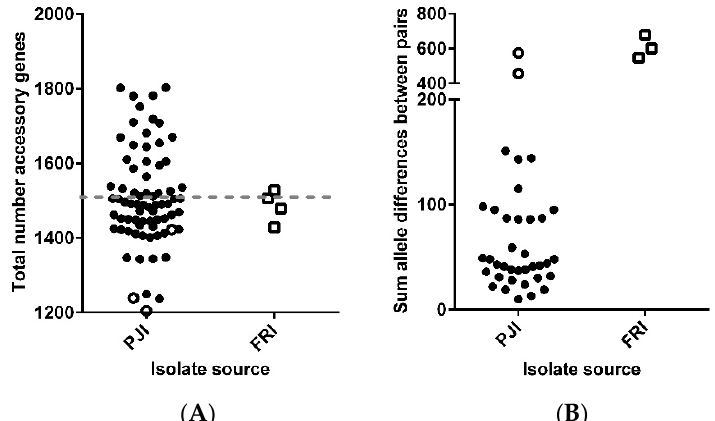
Figure 5. Molecular diversity within the accessory genome of the 77 isolates from 37 patients; ( A ) total number of accessory genes present (dashed line represents average number of genes); and ( B ) sum allele differences within the pairs in 2936 accessory genes. Open symbols represent patients with more than 3 isolates.